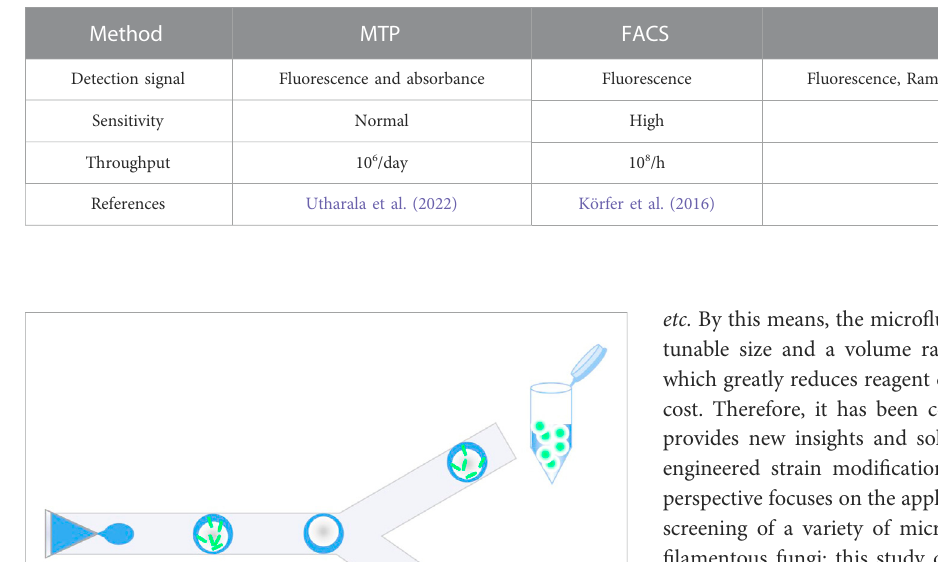
TABLE 1 Differences of MTP, FACS, and DMF for strain screening.